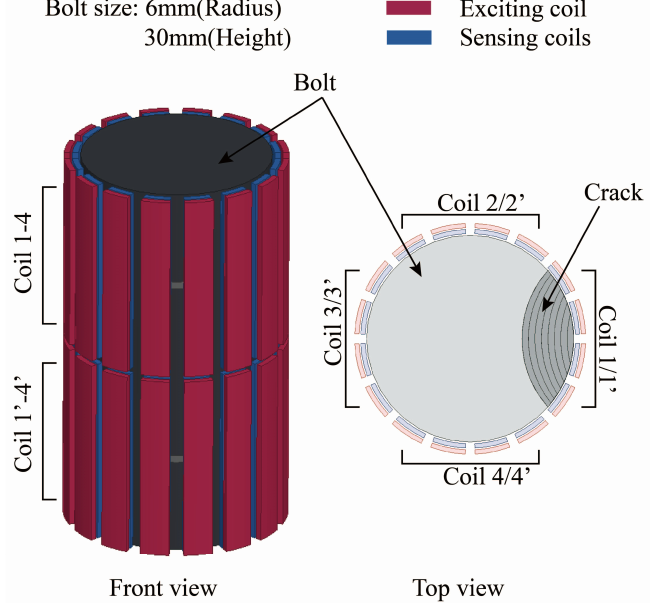
Figure 9. Finite element model of two-dimensional coil array sensing film.